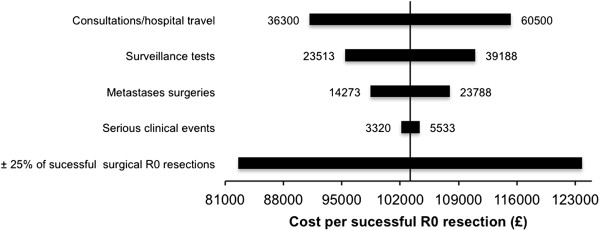
A sensitivity analysis varying the major cost factors. The base case per R0 resection was set as origo (£103,000). Variance in the number of successful R0 metastases resections has a major impact on overall cost (range £ 82,566 to £ 123, 847).